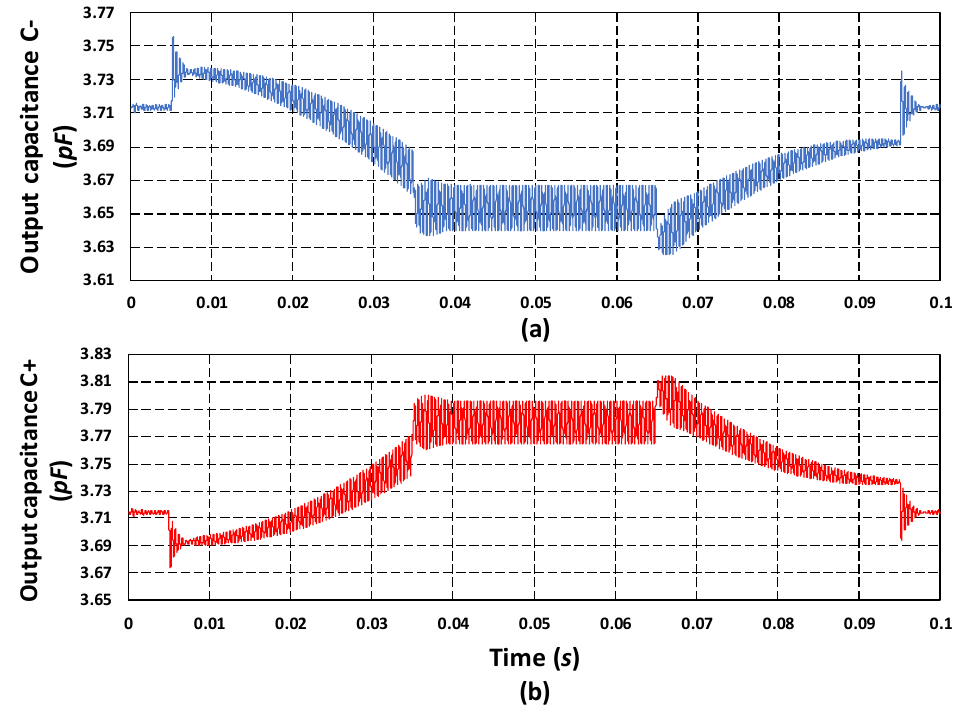
− . ( b ) Output sense capacitance C +